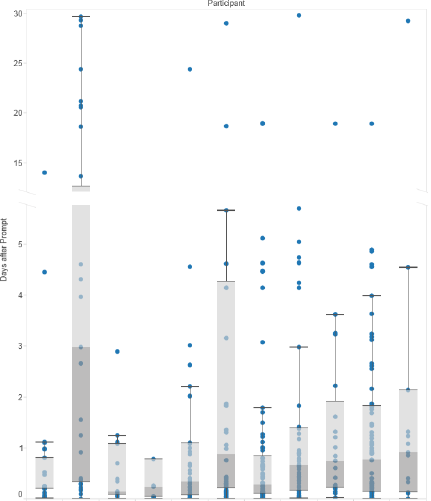
Figure 8. Days untileach participant’s firs commenton a post. P1 and P4 are omittedbecause they spent the entire study